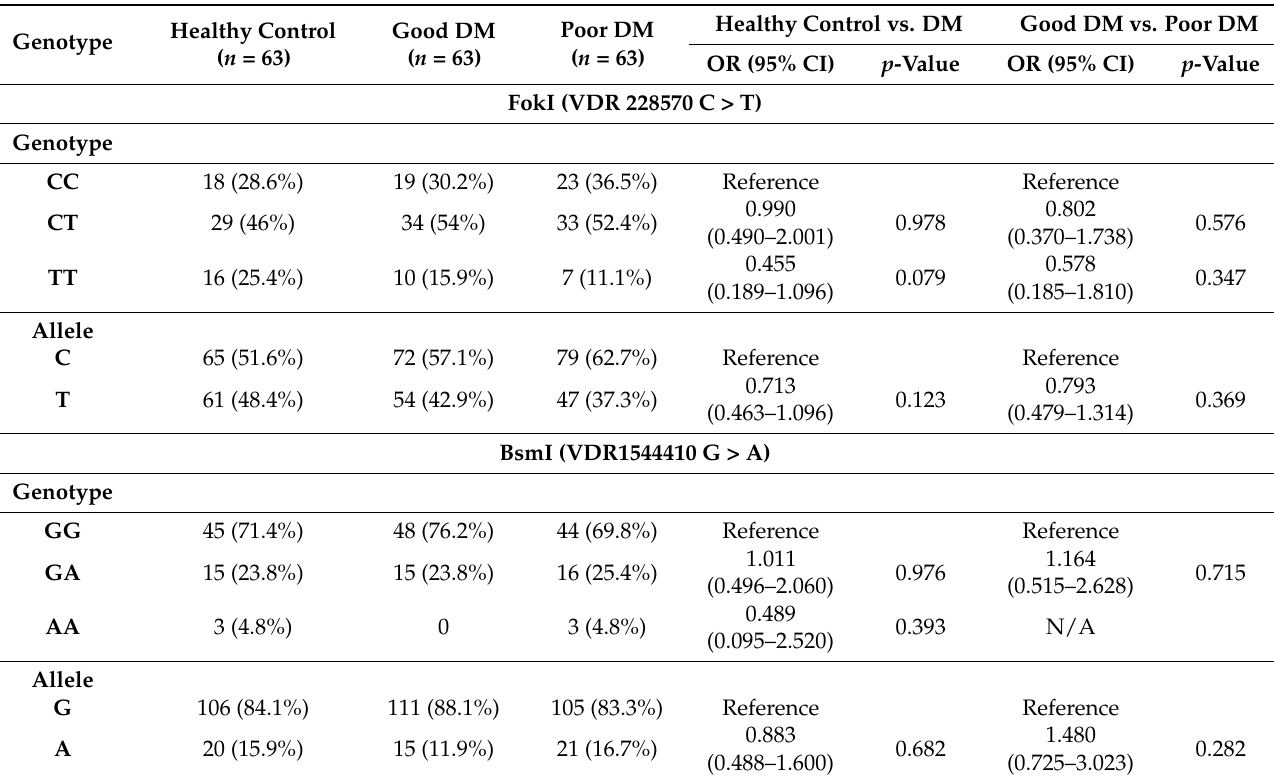
Table 3. Genotype and allele frequency for VDR polymorphism at FokI (VDR 2228570 C > T) and BsmI (VDR1544410 G > A) among diabetic and healthy